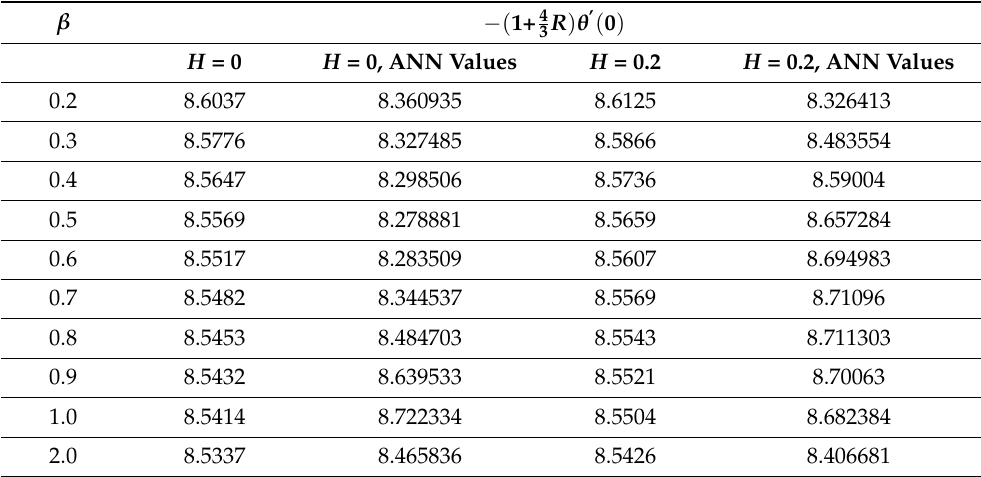
Table 6. Impact of Casson fluid parameter on Nusselt number with and without heat